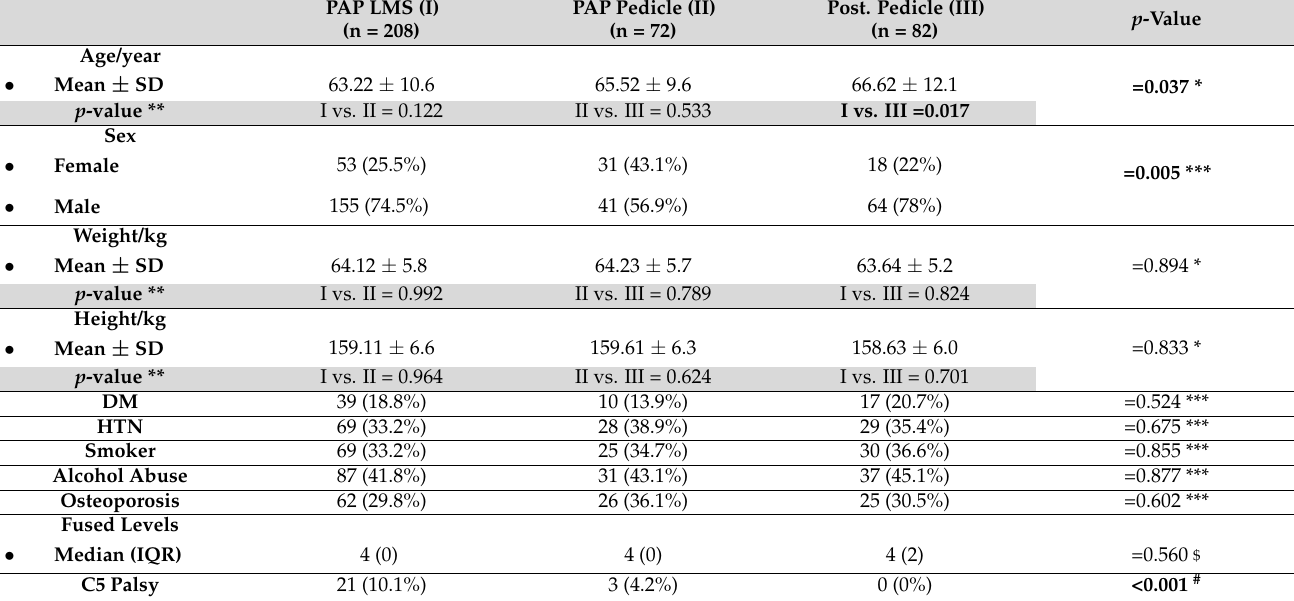
Table 1. Baseline demographic and clinical characteristics of the studied